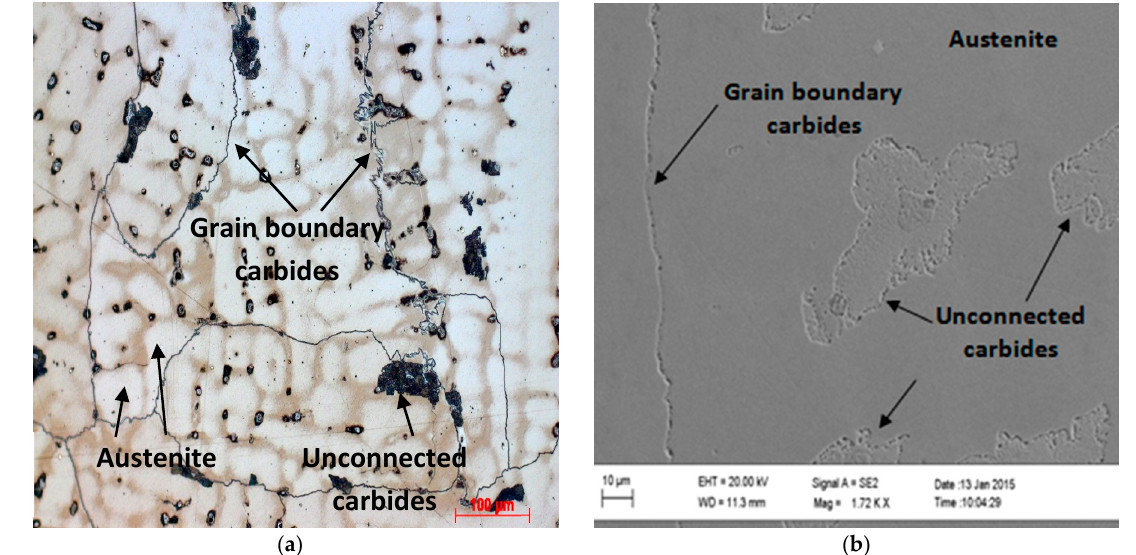
Figure 3. ( a ) Microstructure obtained in as-cast state composed of a fully austenitic matrix, grain boundary chromium-rich carbides and massive carbides in the matrix; ( b ) SEM image of grain boundary carbides and unconnected carbide islands in the as-cast sample.